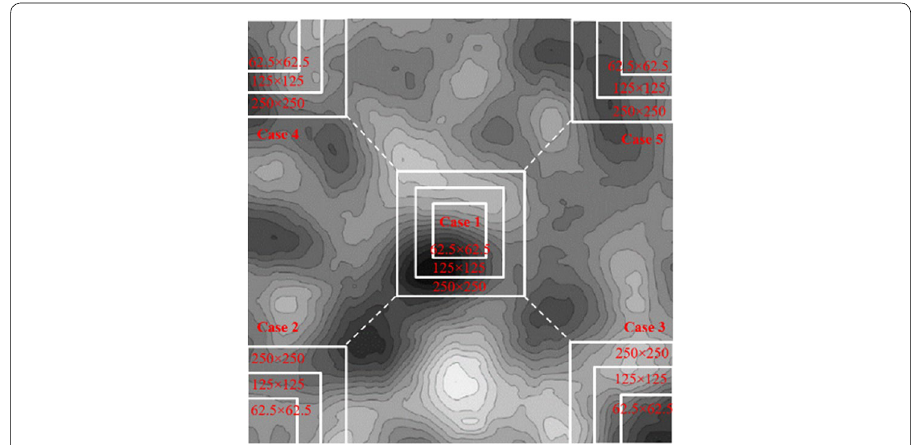
Fig. 7 Division scheme of varisized structure surface